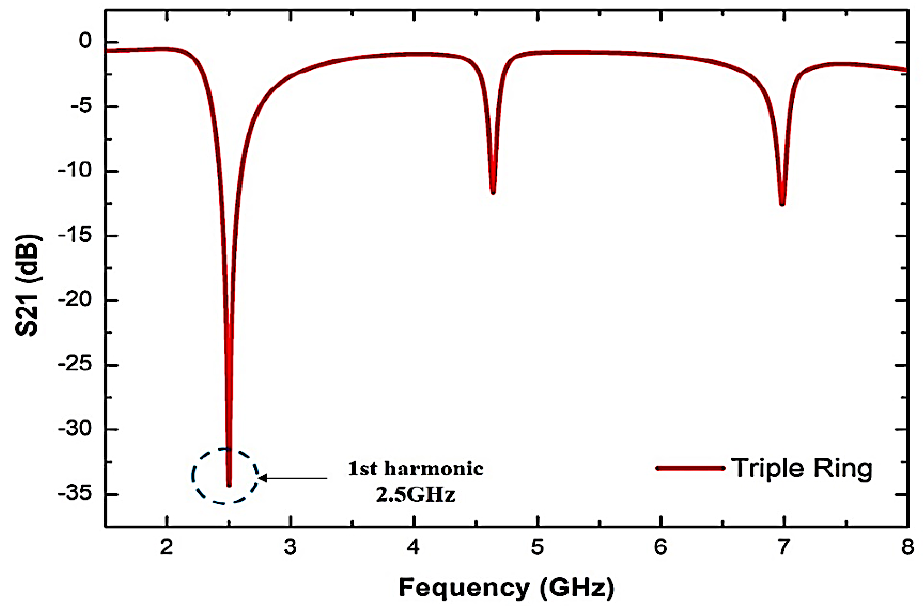
Figure 3. TR curve-feed sensor simulated frequency response.